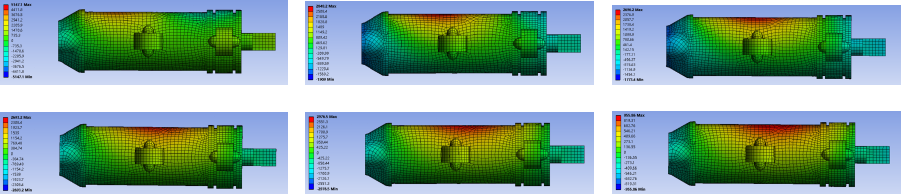
Figure 13. From top to bottom, from left to right: surface pressure nephogram of the Shark-AUV at different submerged depths ( h = 0.6 d, 0.7 d, 0.8 d, 0.9 d, 1 d, 2 d) when the AUV moves in a head wave and is located in the trough with a wave amplitude of 0.4 m.